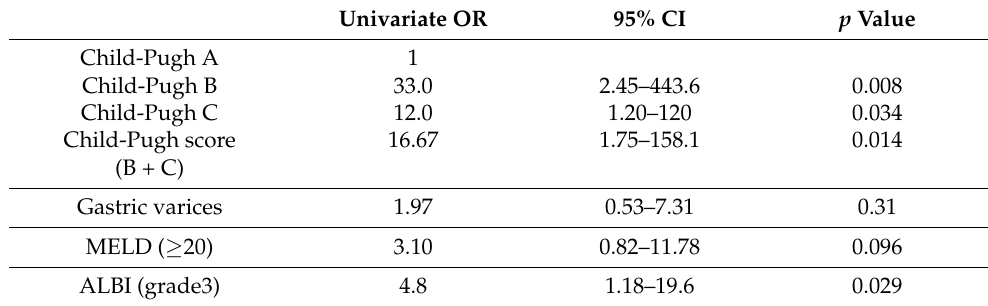
Table 3. Logistic regression analysis for PBUB mortality predictors.